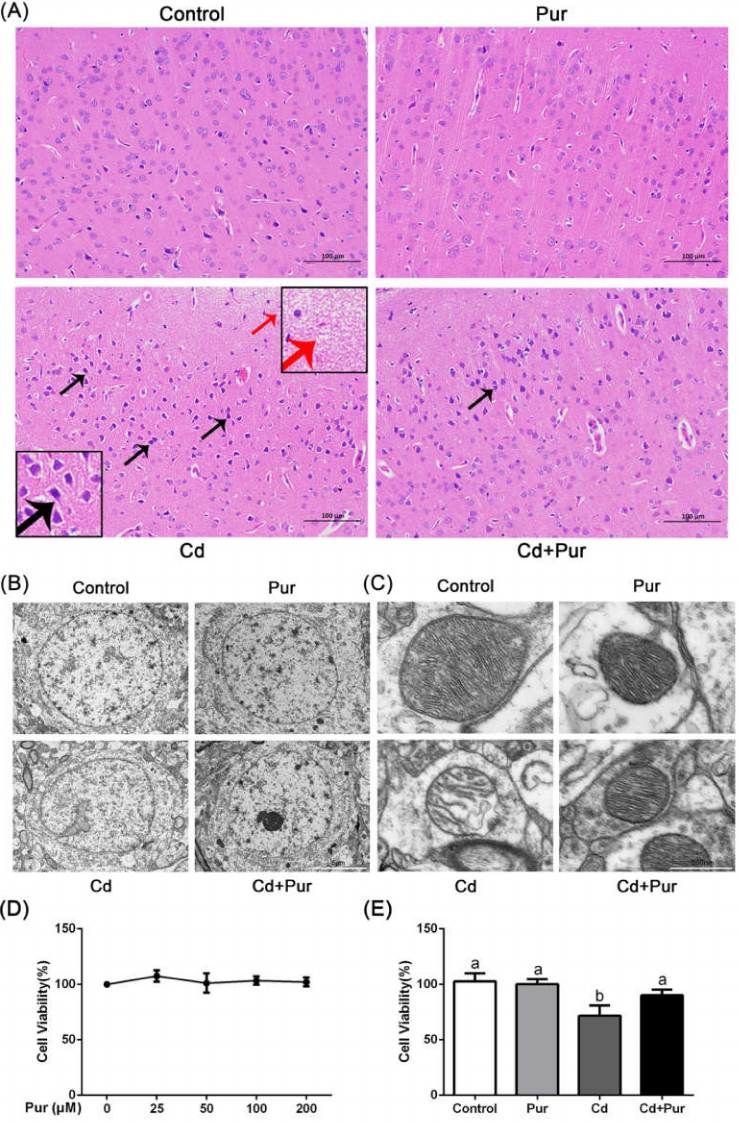
Figure 1. Pur alleviates Cd-induced neuronal injury. Rats were treated with Cd (50 mg/L) and/or Pur (200 mg/kg) for 90 days. ( A ) H&E staining of the rat cerebral cortices of each group. A period of 90 days of Cd exposure induced the formation of microscopic voids in the cortex (red arrows), neuronal deep staining, unclear boundaries between the cytoplasm and nuclei, as well as gaps around the neurons (black arrows). Treatment with Pur attenuated Cd-induced neuronal injury in the rat cerebral cortices. Scale bars: 100 µ m. Representative electron microscopy images show the ( B ) nuclei and ( C ) mitochondria in the rat cerebral cortices of each group. Scale bars: ( B ) 5 µ m and ( C ) 500 nm. ( D ) Primary cortical neurons were treated with different concentrations of Pur (0 µ M–200 µ M) for 12 h. Cell viability was detected using a CCK-8 assay. ( E ) Primary cortical neurons were pretreated with 100 µ M Pur for 1 h, followed by exposure to 10 µ M Cd for 12 h, after which the cell viability was detected via a CCK-8 assay. Data are expressed as the mean ± SD ( n = 4). The means labeled without a common letter (a, b) are significantly different, p <